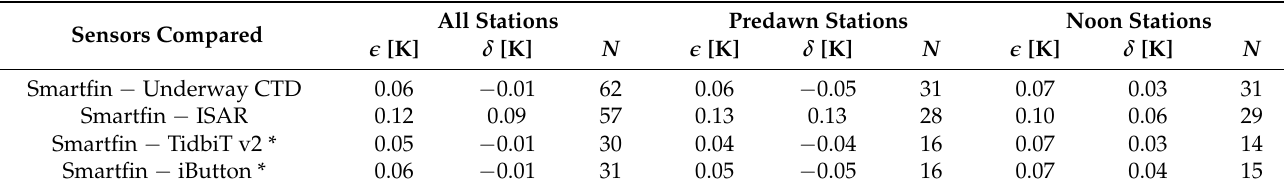
Table 1. Mean absolute differences ( (cid:101) ) and mean differences ( δ ) between SST datasets collected on the Atlantic Meridional Transect cruise 28, using the Simple Oceanographic floating Device (SOD), ISAR and underway systems ( N = number of stations).